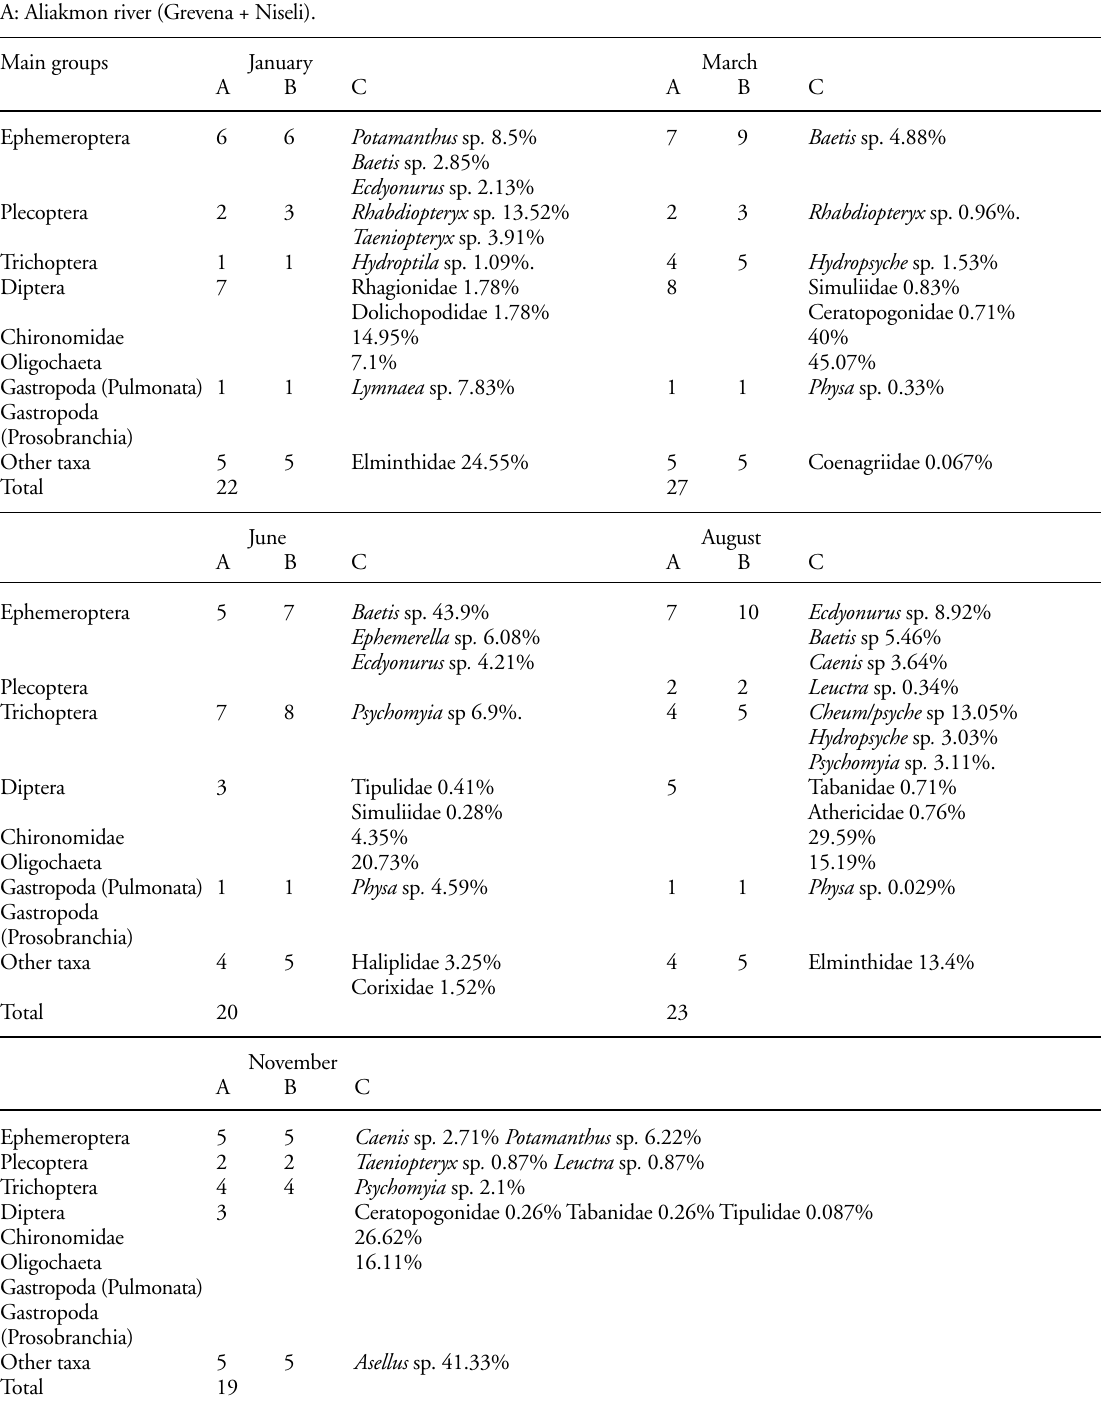
Table 10. Percentages of the taxa at Aliakmon River (Grevena + Niseli) (A), Axios river (B), Olympias area (C), Skouries area (D). Other taxa may be Odonata, Coleoptera, Hemiptera, Hirudinea, Amphipoda, Isopoda or/and Crustacea. (A: number of families, B: number of genera, C: dominant taxa). A: Aliakmon river (Grevena +